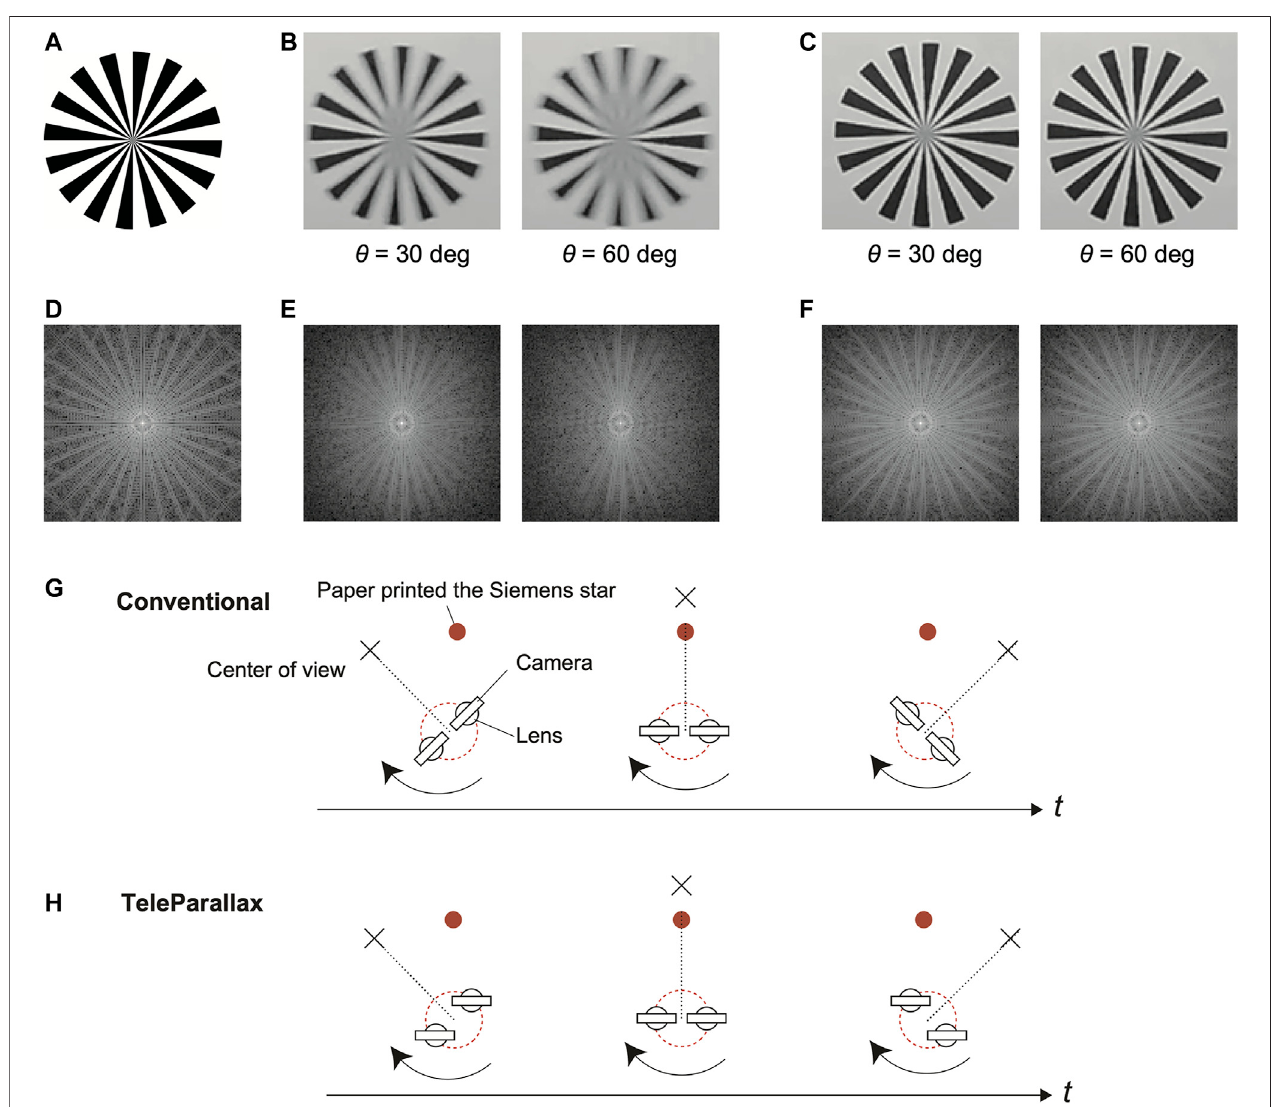
FIGURE 7 | Original image of the Siemens star (A) . Images captured during head motion with the conventional two side-by-side omnidirectional cameras (B) and ourproposedsystem (C) .Here, θ istheamplitudeoftheyawrotation.Powerspectraoftheoriginalimage (D) ,thecapturedimagefortheconventionalsetup (E) ,andthat forourproposedsystem (F) .MeasurementoftherotationofthecamerastocaptureanimageoftheSiemensstartestpatternforaconventionalstereocamerasetup (G) and (H) . The total amount of rotation θ was 30 or 60 ° .